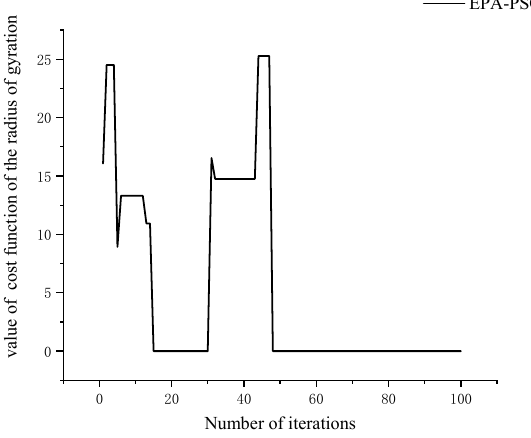
Figure 32. Value of energy cost function of EPA-PSO algorithm after 100 iterations.